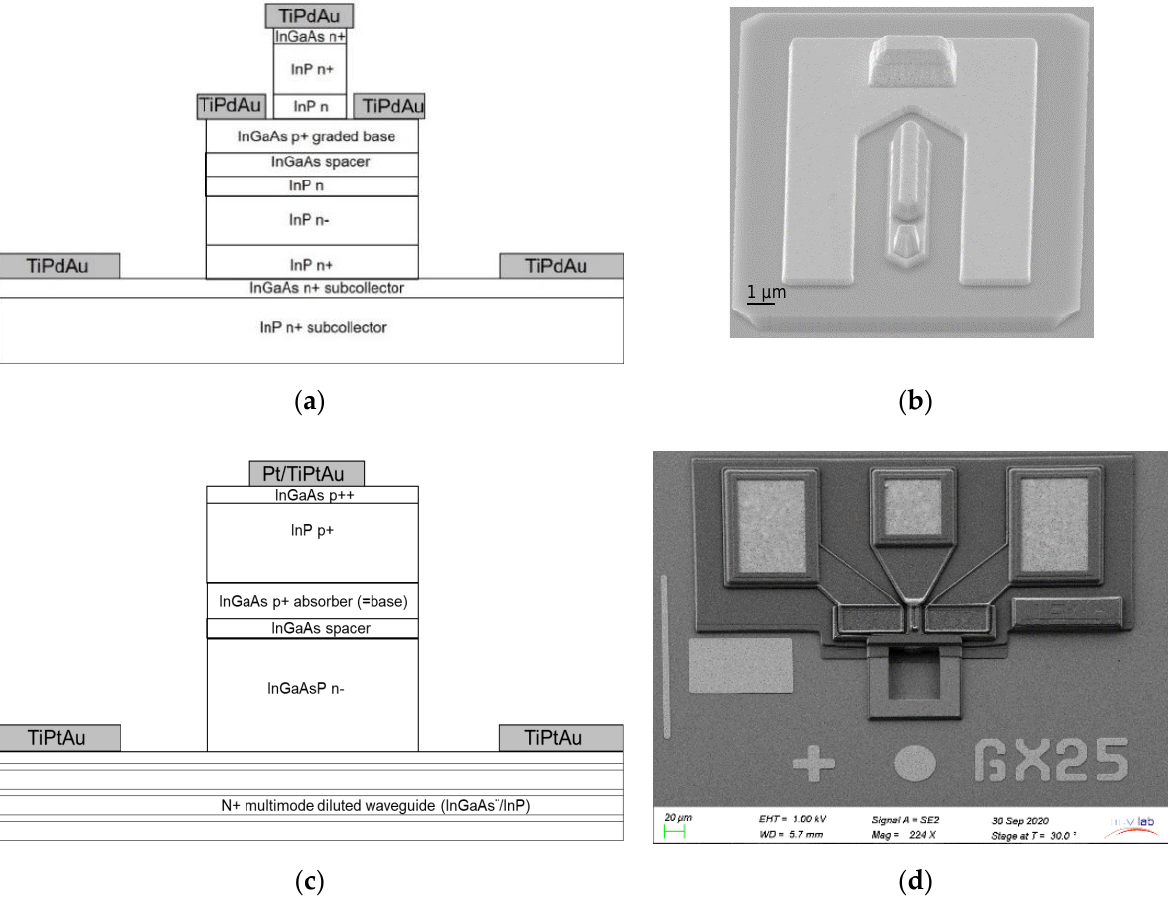
Figure 2. ( a ) Simplified schematic cross-sectional view of submicrometer InP/InGaAs double heterojunc-tion bipolar transistors (DHBTs) and ( b ) Scanning electron microphotographs of a 0.7 × 5 µ m 2 InP DHBT before metal interconnection level; ( c ) Simplified schematic cross-sectional view of a waveguide uni-traveling carrier photodiode (UTC-PD), ( d ) Scanning electron microphotographs of a 5 × 25 µ m 2 InP UTC photodiode after metal in-terconnection